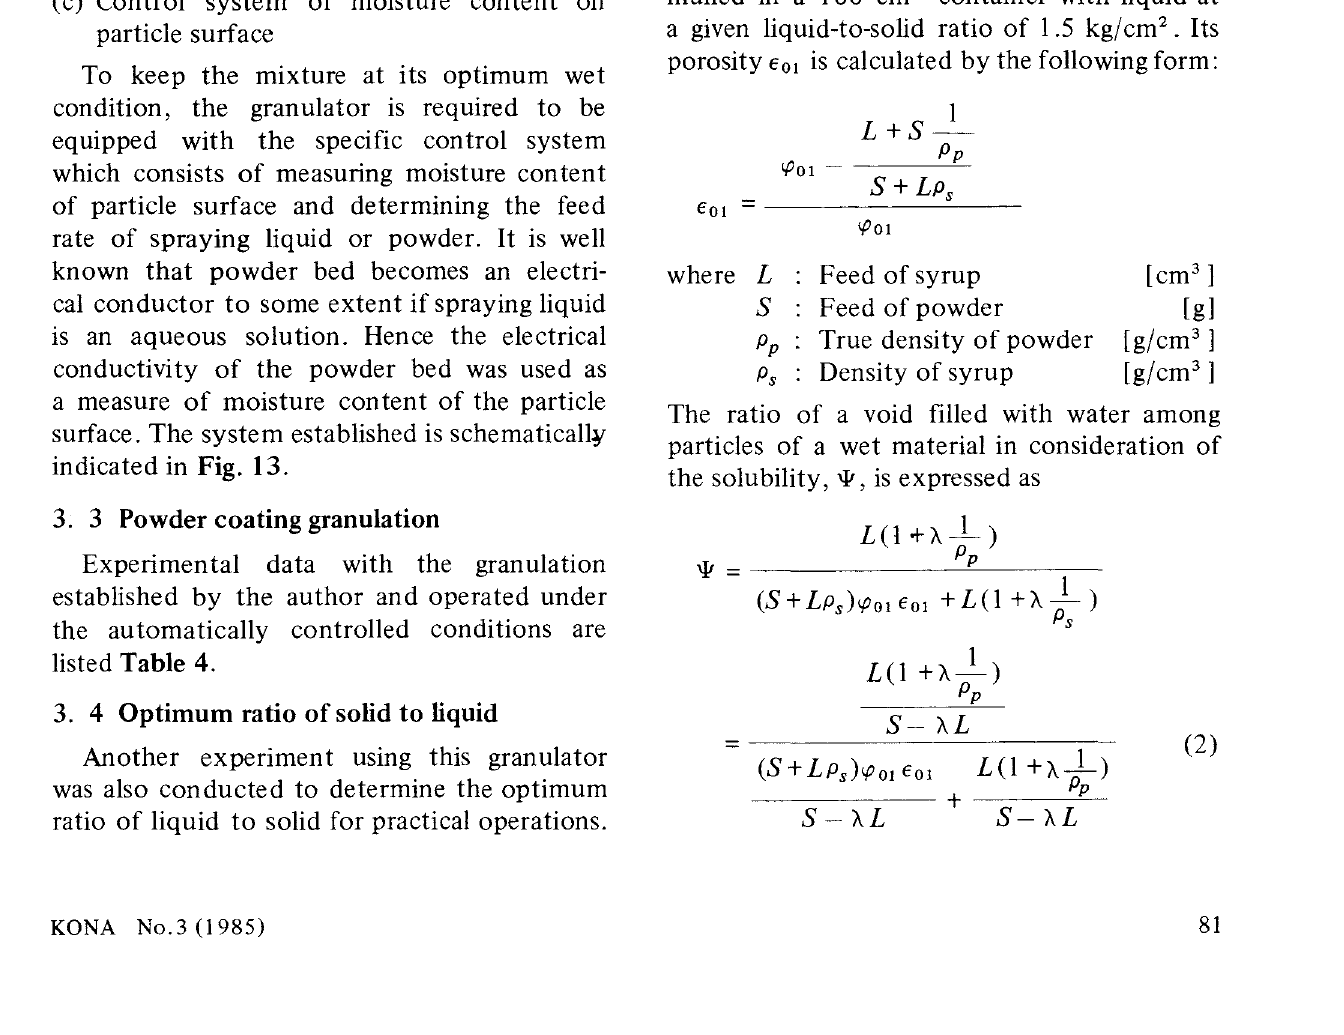
Fig. 13 Control system for powder coating